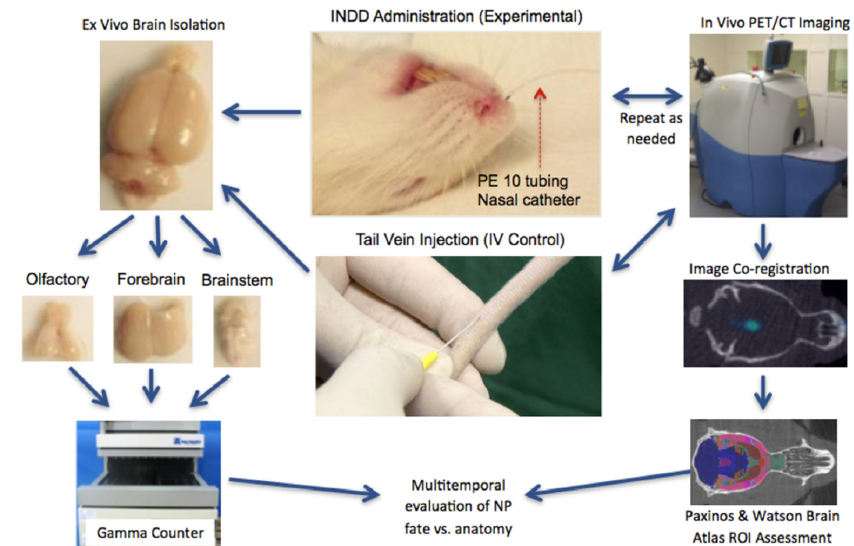
Figure 1. Intranasal drug delivery (INDD) workflow followed by positron emission tomography/computer tomography (PET/CT) imaging at 1 and 2 h. Each rat was placed into a customized induction chamber and anesthetized; and nanoparticles (NPs) were delivered intranasally for the experimental portion of the study or by IV via the tail vein for the control portion of the study. The rat was transferred into the PET/CT unit for imaging at various time points. The acquired images were used to manually define the three-dimensional (3D) regions of interest (ROIs). The intracranial intensity data from the PET and the corresponding CT scan were co-registered and imported into post-processing image analysis software for brain segmentation and subregion measurement. After imaging, the brain of the animal was isolated, and the brain subregions were dissected into the olfactory bulb, brainstem, and forebrain. The tissue was placed in a gamma counter for quantitative subregional assessment. Finally, the in vivo and ex vivo data were analyzed and compared for multi-temporal evaluation of the nanoparticles’ fate within the various anatomical regions of the brain.